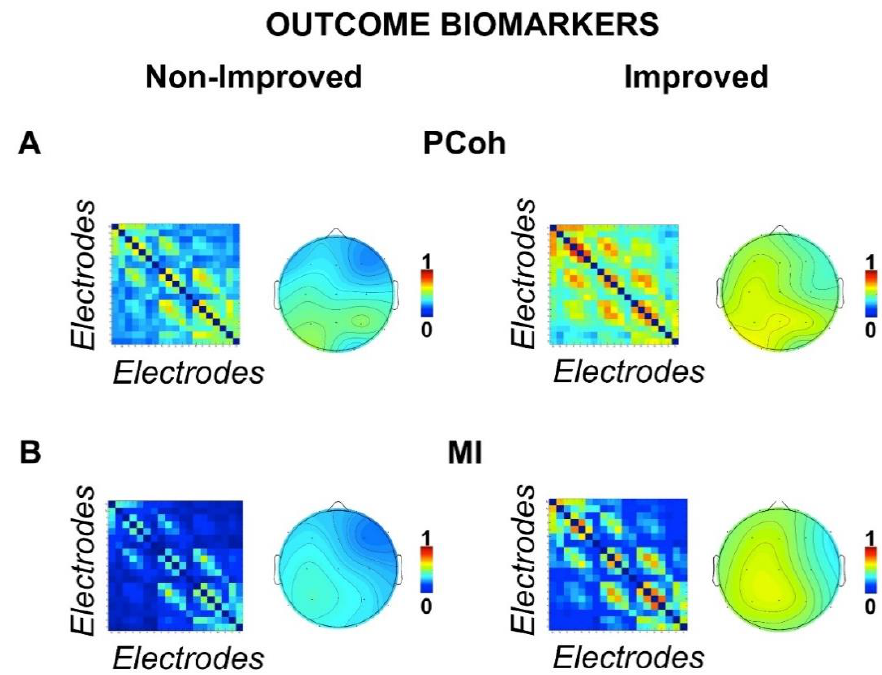
Figure 2. Outcome biomarkers. Connectivity matrices between scalp electrodes of the ( A ) partial coherence (PCoh) and the ( B ) mutual information (MI) for improved and nonimproved patients. Both figures show stronger connectivity for improved patients. Topographies show grand mean PCoh and MI connectomes for each electrode.